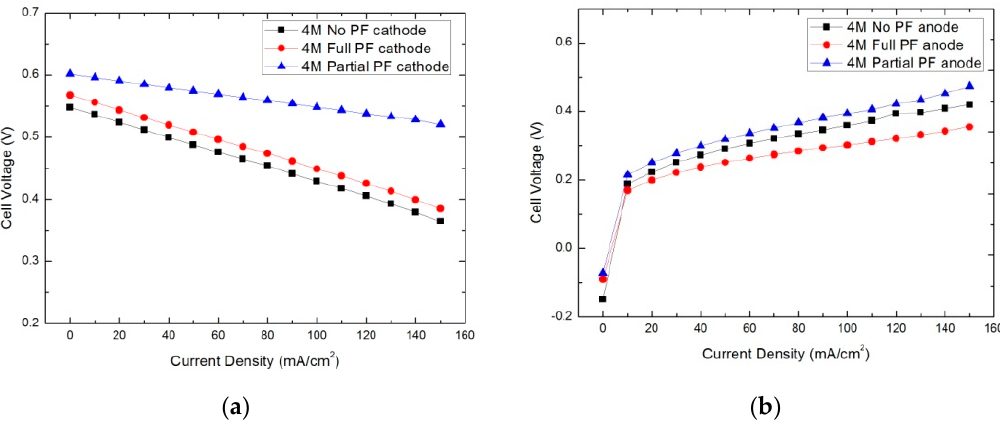
Figure 6. Cathode and anode potential of no PF cathode, full PF cathode, and partial PF cathode with 4 M methanol solutions at 298 K: ( a ) cathode potential; ( b ) anode potential .